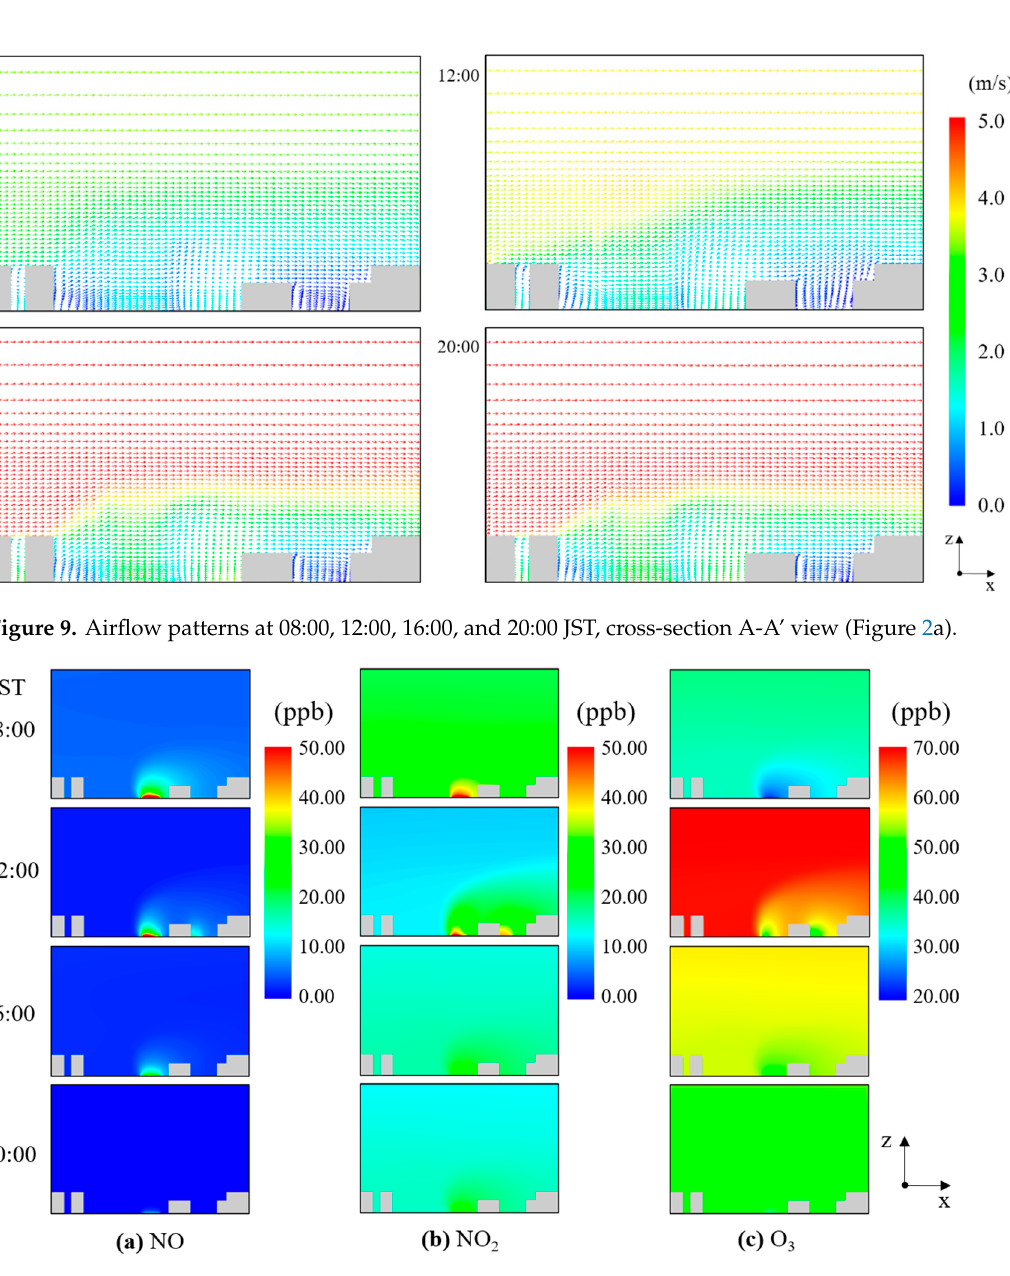
Figure 10. Spatial distribution of ( a ) NO, ( b ) NO 2 , and ( c ) O 3 concentration at 08:00, 12:00, 16:00, and 20:00 JST, cross-section A-A’ view (Figure 2a).